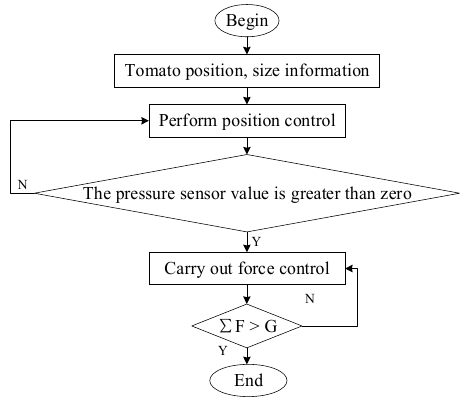
Figure 1. Flow of the hybrid force/position control strategy. three-dimensional contour. The standard ellipsoidal curve is shown in Equation (1),